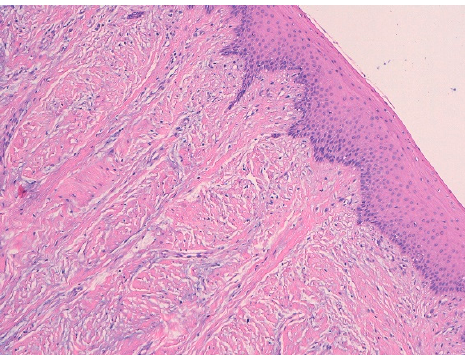
Figure 6. Histological findings of the biopsied sample: the squamous-lining oral mucosa with parakeratosis and pseudoepitheliomatous hyperplasia.